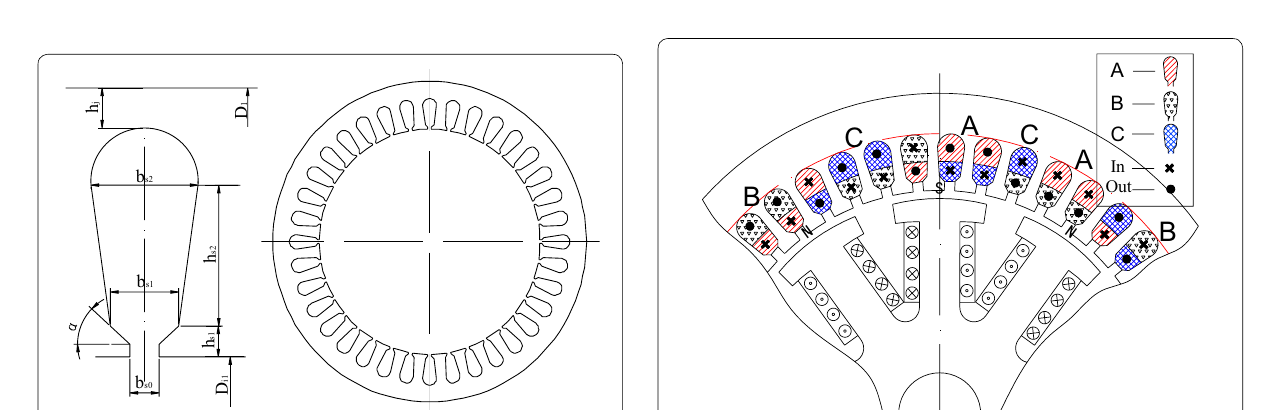
Figure 6 Pyriform slot and stator stamping